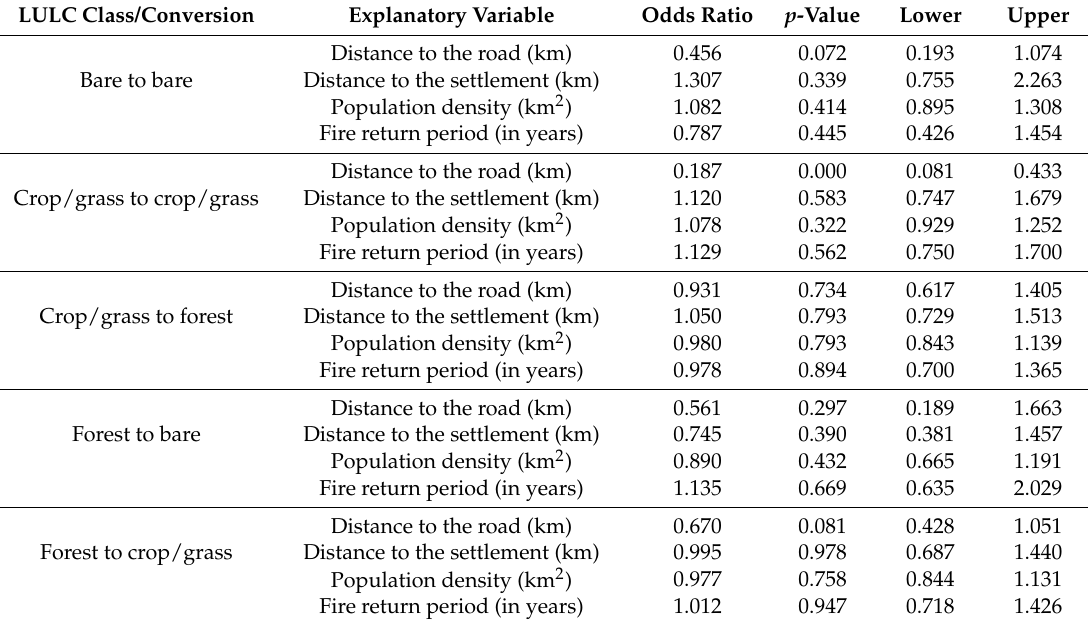
Table 7. Factors affecting the LULC class/conversion in the communal area.